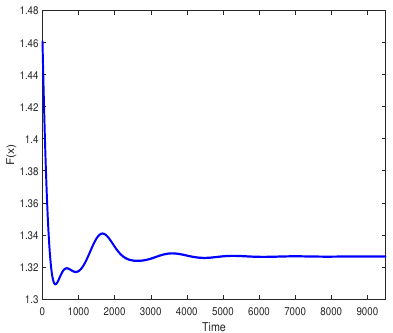
Figure 8. The cost function F ( t )